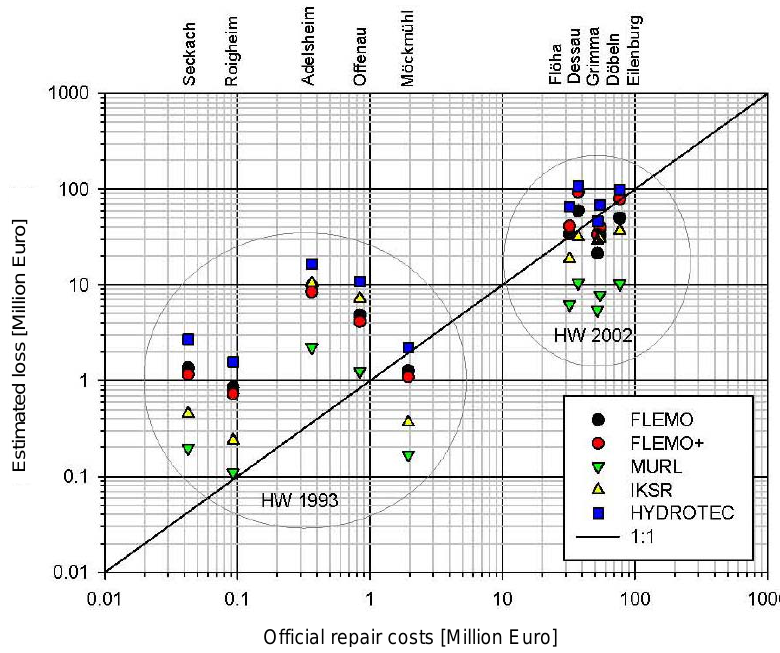
Fig. 3. Official repair costs and estimated building damages in ten municipalities that were affected by flooding in 1993 or in 2002 (Thieken et al.,